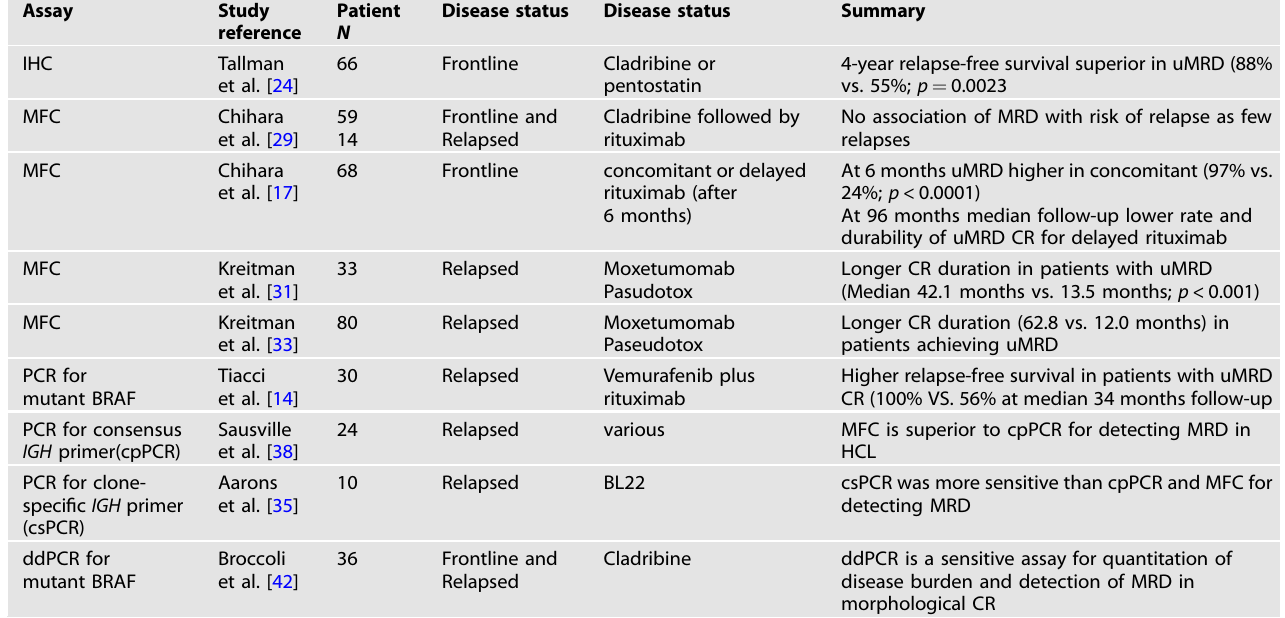
Table 2. Selected studies/assays utilized for MRD assessment in